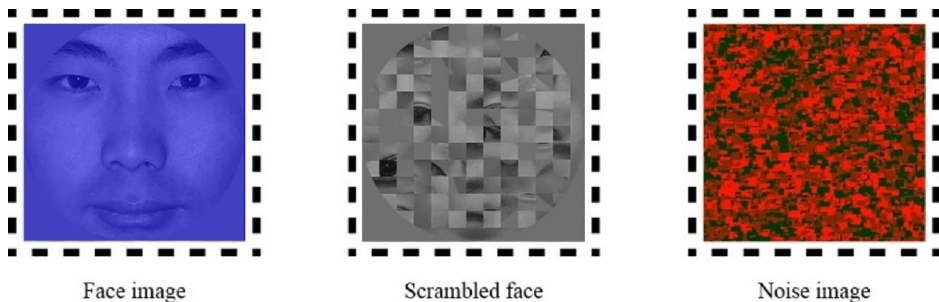
Figure 1. Experimental stimuli images.